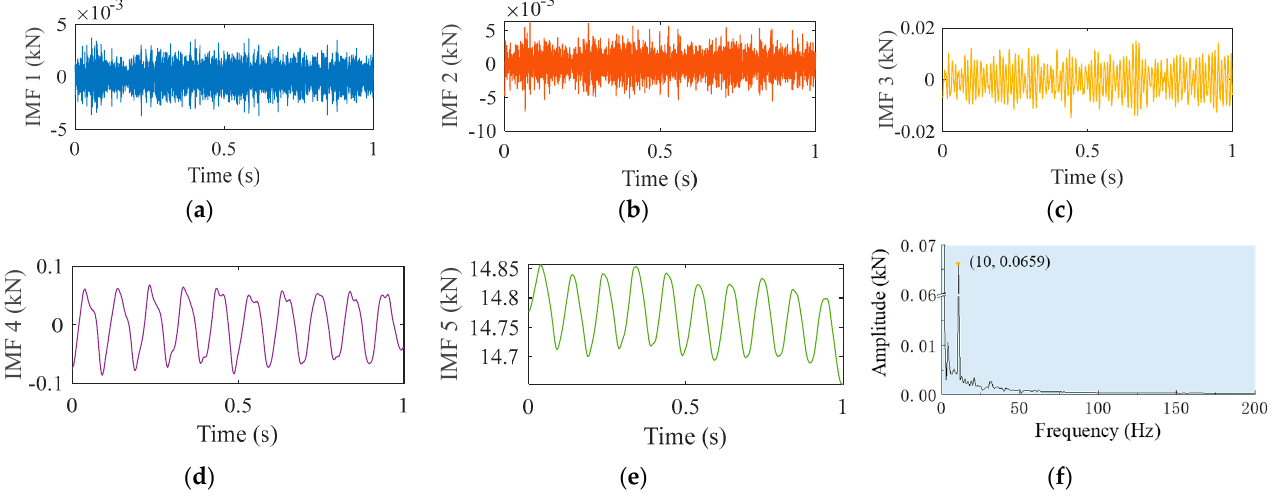
Figure 5. VMD results of denoised axial force Fz: ( a ) IMF1; ( b ) IMF2; ( c ) IMF3; ( d ) IMF4; ( e ) IMF5; ( f ) frequency spectrum of IMF5.